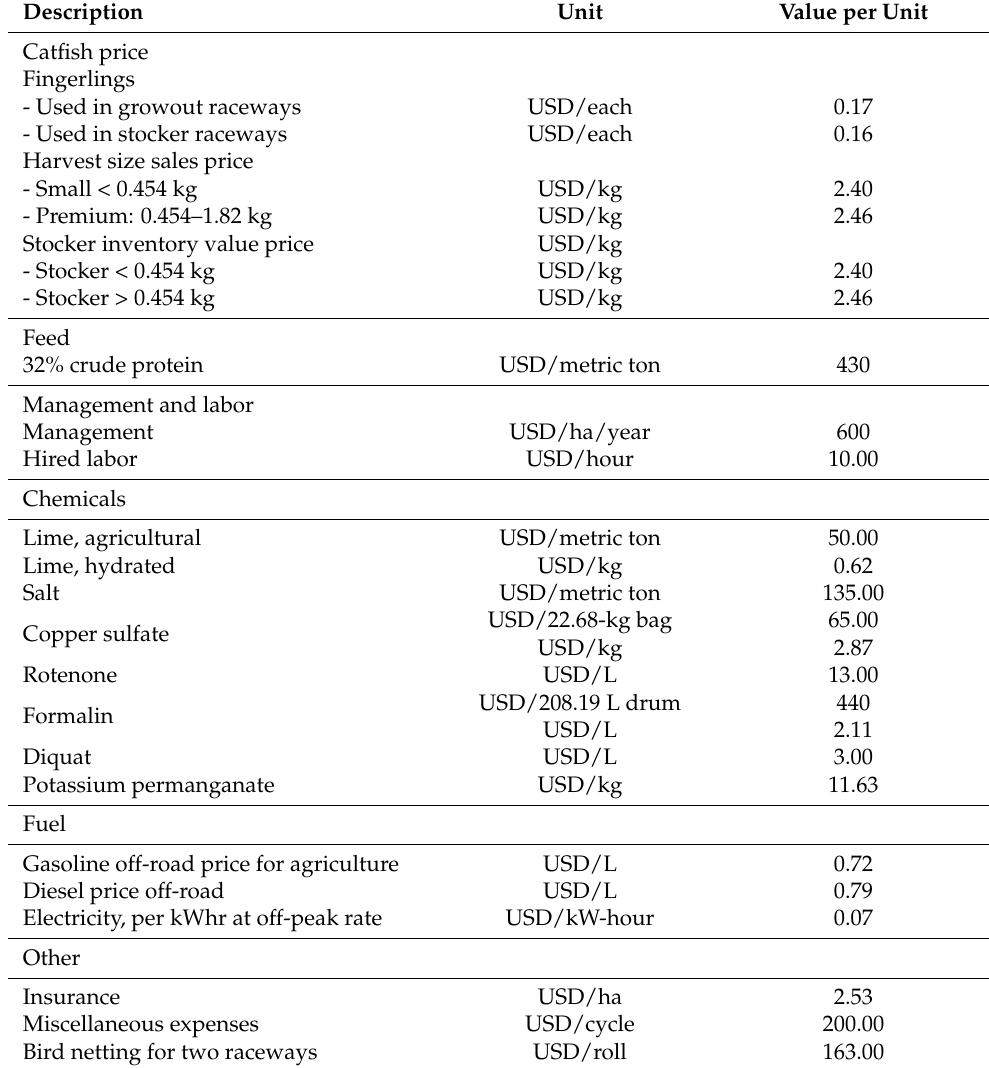
Table 1. Per-unit value or cost used in the development of the in-pond raceway system (IPRS) enterprise budgets for stocker and foodsize hybrid catfish (channel catfish Ictalurus punctatus catfish, I. furcatus